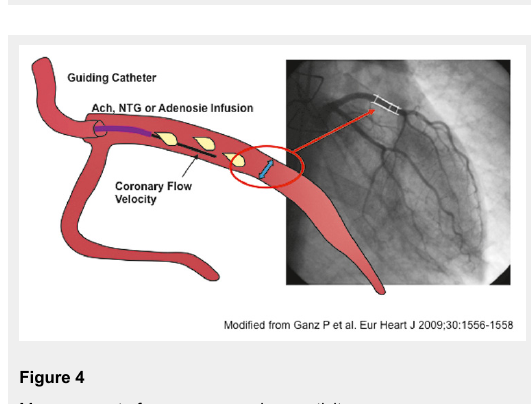
Measurement of coronary vascular reactivity. Small catheters are positioned in proximal coronary arteries. Acetylcholine or nitroglycerin are infused to test conduit vessel endothelium-dependent and -independent vasodilatation respectively. Changes in vascular diameter are measured by quantitative coronary angiography. Doppler flow-velocity measurements are used to assess small vessel vasoreactivity to acetylcholine and adenosine respectively. Modified from Ganz